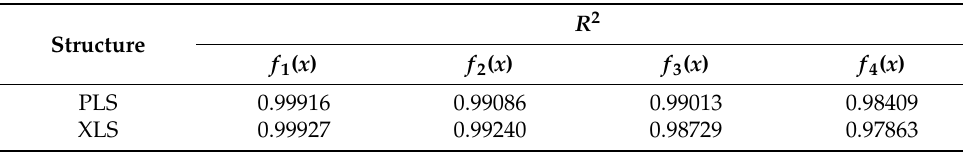
Table 2. Fitting accuracy of approximate models for PLS and